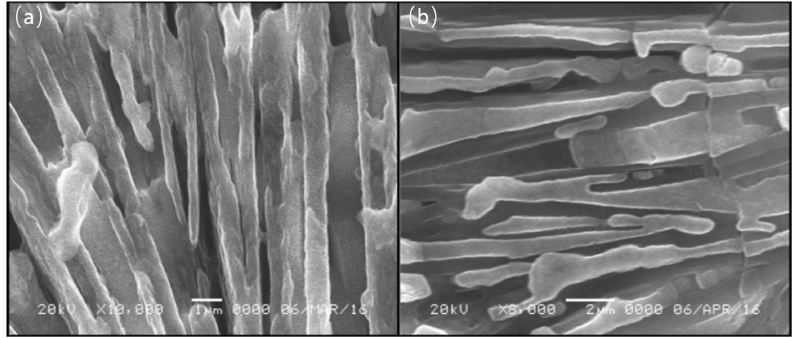
Figure 5. Scanning electron micrographs ( a ) 0.5LiNH 2 ‐ 0.5NaH system ( b ) 0.5LiNH 2 –0.5KH sys ‐ tems.